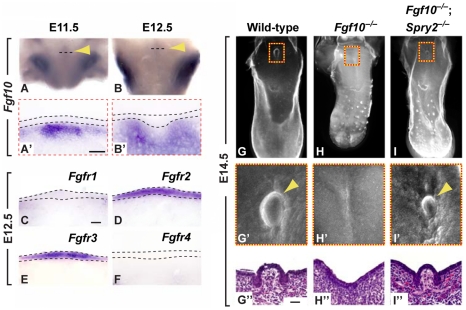

Fgf10 is required for CVP development and is antagonized by Spry2.(A–B') Expression of Fgf10 in the CV placode of wild-type mice (arrowhead). Dashed line depicts the coronal plane of section for A' and B'. (C–F) Expression of FGF receptors (Fgfr1-4) in coronal sections. (G–I”) Genetic rescue of the loss of CVP phenotype in Fgf10−/− mice (H) by deletion of Spry2 (I) as visualized by E-cadherin immunofluorescence staining. (G'–I') Higher magnification views of boxed areas. (G”–I”) H&E staining of coronal sections through the CVP. Scale bars, 25 µm.